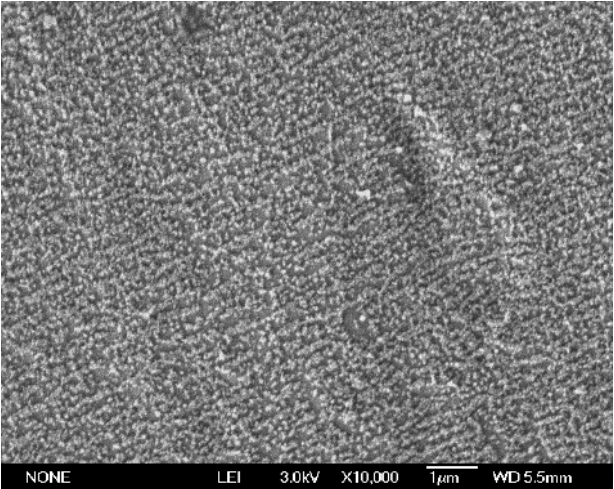
* The standard parameters used in the preparation of TiO 2 layer on substrates by Spray-ILGAR method for the preparation of solar cells.